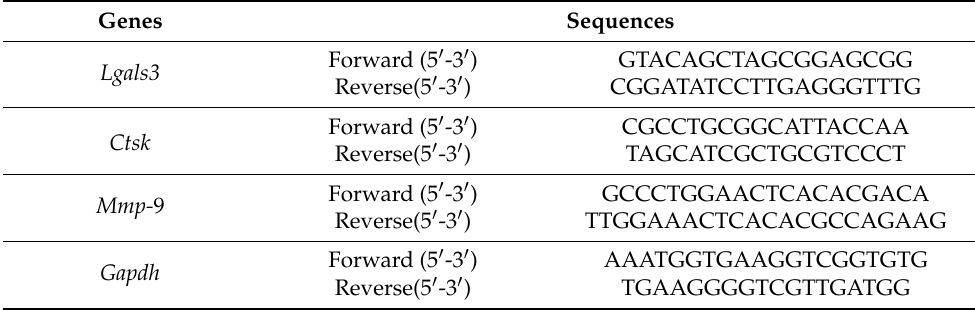
Table 1. Sequences of PCR primers used in this